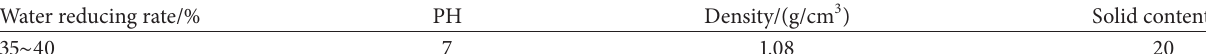
Table 5: Properties of high-efficiency water reducer.